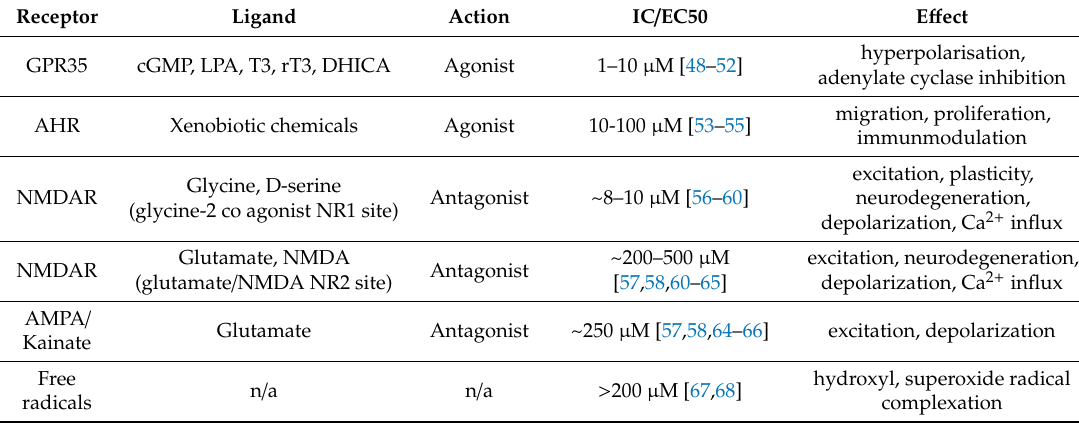
Table 1. Major binding sites and actions of kynurenic